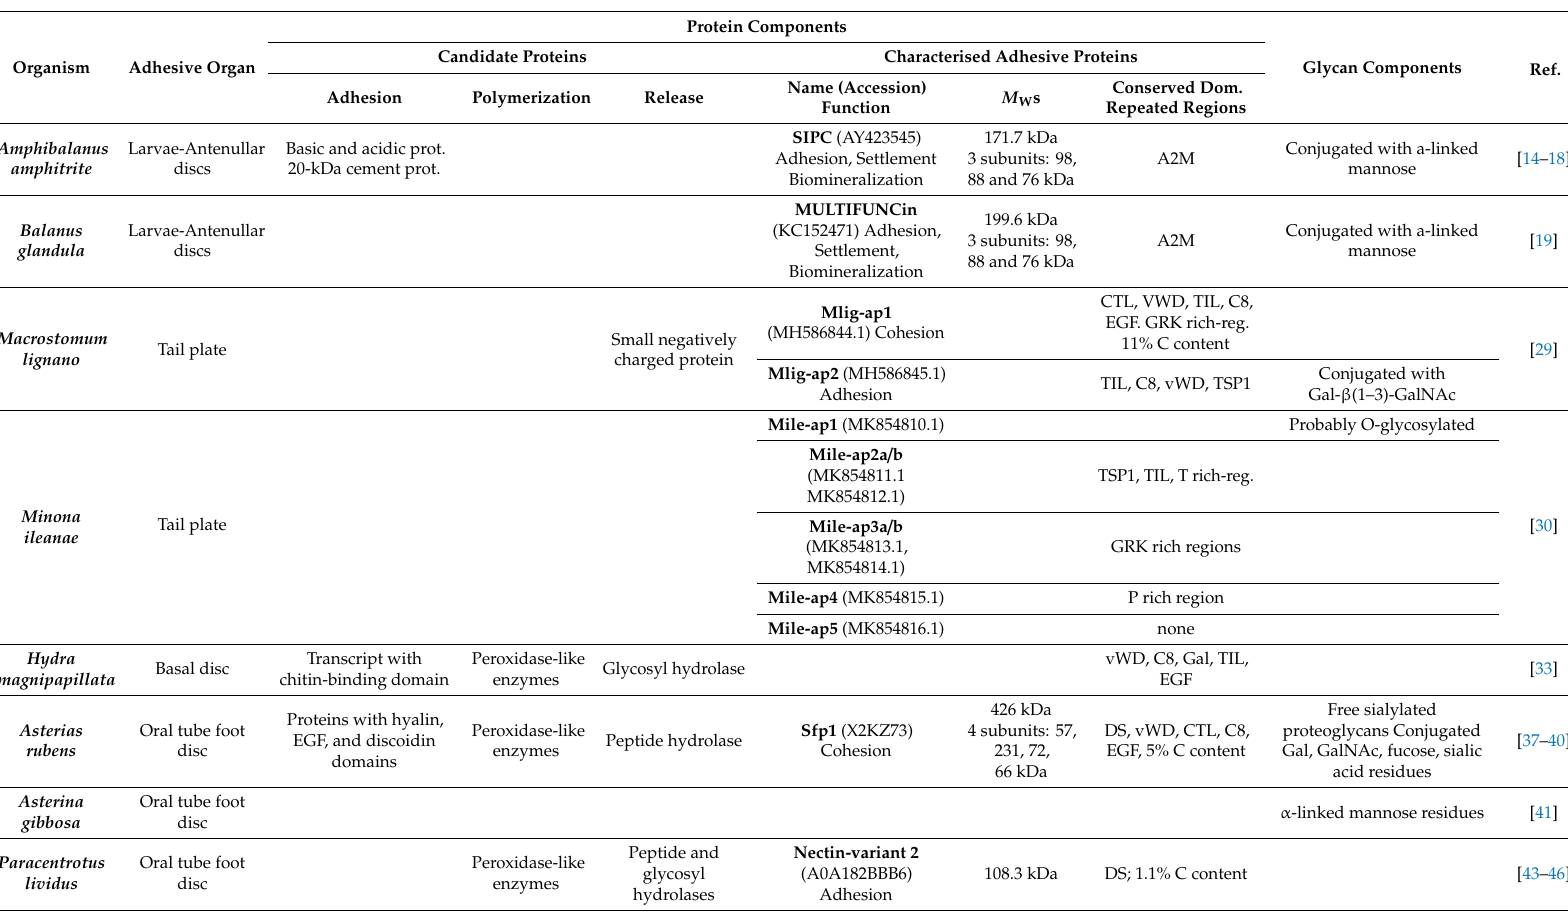
Table 1. Common molecular features between non-permanent adhesives. Abbreviations: A2M—alpha macroglobulin domain; C8—cysteine-rich domain; C content—Cysteine content; CTL—C-type lectin domain; DS—Discoidin-like (F5 / 8 type C) domains; EGF—EGF-like calcium-binding domain; GRK